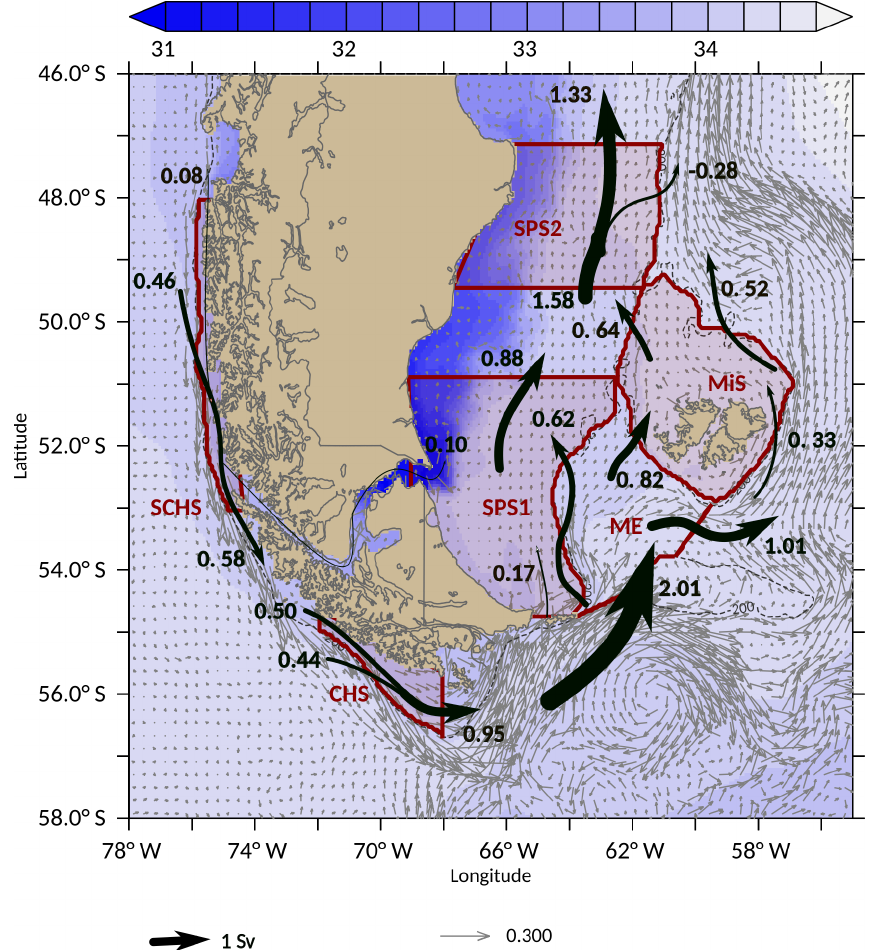
Figure 2. Mean total schematic transport over 27 years in the upper layer (0–200m) calculated from CMM on the southern Chilean Shelf (SCHS), Cape Horn shelf (CHS), southern Patagonian Shelf (SPS1 and SPS2), the Malvinas Shelf (MIS), and the Malvinas Embayment. The color bar represents the mean surface salinity from the model, and vectors represent the full mean depth-averaged velocity (surface to bottom). Black arrows and values indicate the integrated transport across each